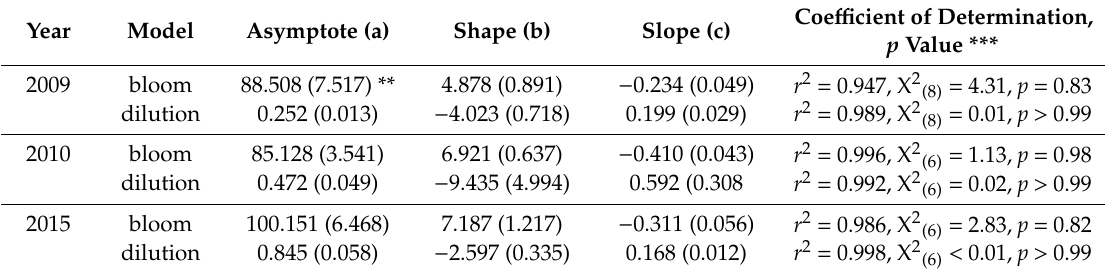
* equation 1; ** values in parentheses are standard errors. *** Coe ffi cient of determination ( r 2 ) was approximated for non-linear model, p value is based upon model goodness of fit to data (Chi-square test), comparison of observed sums of squares to that expected based upon a gaussian theoretical frequency